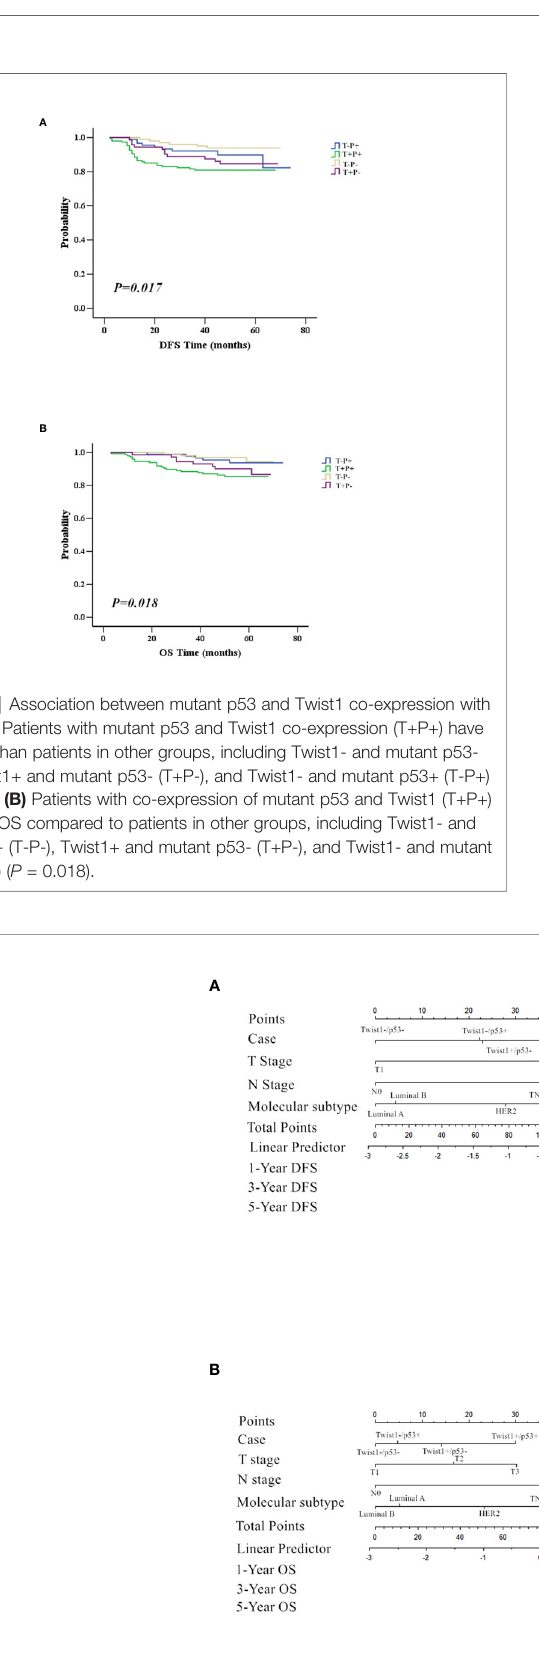
FIGURE 5 | Nomogram for predicting DFS (A) and OS (B) in the